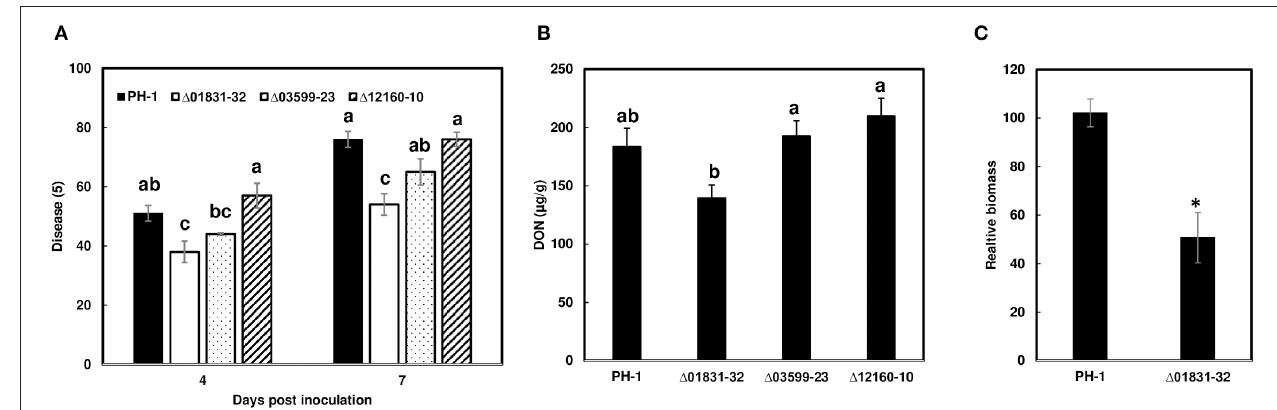
FIGURE 4 | Impact of the effector mutants on initial infection, DON content, and fungal biomass on wheat heads. Inoculations were performed by immersing whole heads of wheat cv. Alsen in suspensions of F. graminearum PH-1 and mutants 1 01831-32, 1 03599-23, and 1 12160-10, respectively, (5 × 10 4 conidia/mL). (A) FHB was scored as the percentage of florets with visual symptoms at 4- and 7-days post inoculation (dpi). Bars represent the average percentages and standard error of 24 inoculated heads with each strain. The statistical analyses were performed for each time point independently. (B) DON was extracted from tissues at 7 dpi and analyzed by GC/MS. (C) Comparison of fungal biomass relative to wheat tissue in infected wheat heads between PH-1 and mutant 1 01831-32. Relative biomass was calculated based on qPCR Ct values of fungal TRI6 vs. the corresponding Ct values for the wheat gene GAPDH. Letters indicate significance based on one-way analysis of variance (ANOVA) and Dunnett’s test using JMP. The asterisk (*) indicates significant difference at the P < 0.05 level by Student’s t -test.